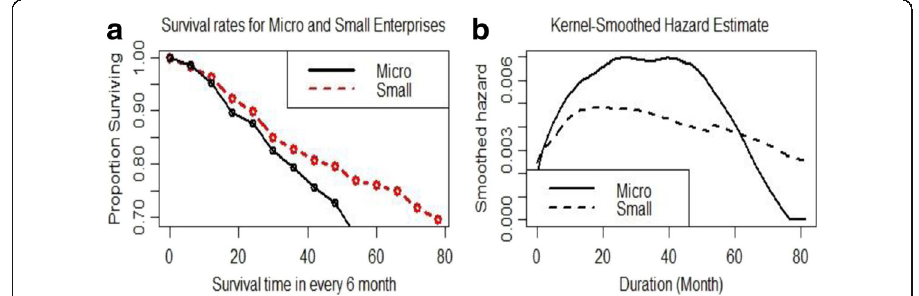
Fig. 2 The survival and hazard rate deferential between micro and small enterprises. a Survival rates for micro and small enterprises. b Kernel-smoothed hazard